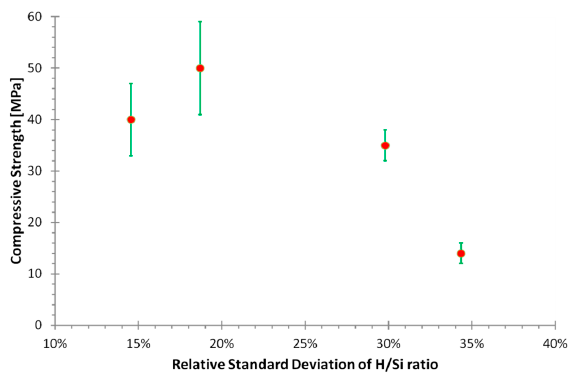
Figure 6. The relative standard deviation of calculated atomic H/Si in solution during geopolymer phase growth (between 10% and 90% of relative geopolymer concentration). Note, the formation of geopolymer and zeolite-like phases was not accounted for and the inverse correlation between compressive strength and the variability of the solution.